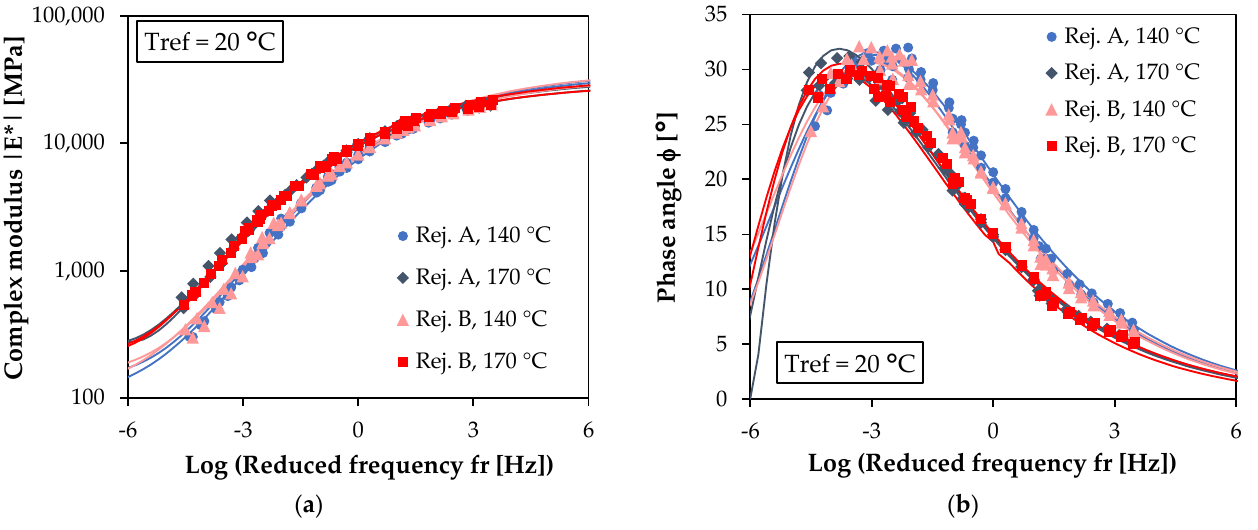
Figure 9. Master curves of the tested specimens: ( a ) Complex modulus | E *|; ( b ) Phase angle ϕ . The HMA production temperature also influenced the phase angle values (Figure